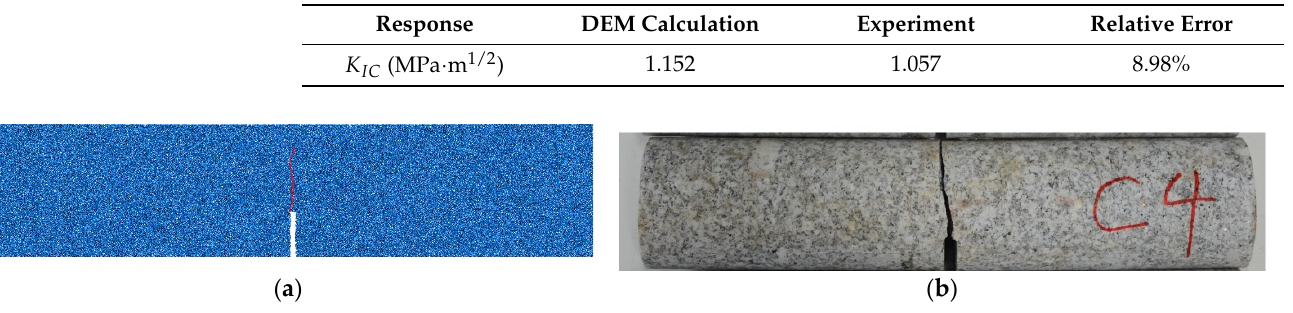
Figure 15. Comparison of simulated and experimental destruction result for three-point bending experiment. ( a ) DEM calculation result; ( b ) Experimental result.